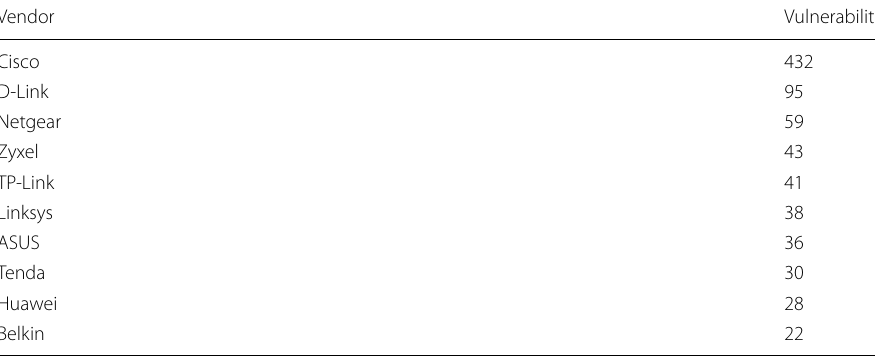
Table 4 Top 10 vendors by total number of vulnerabilities